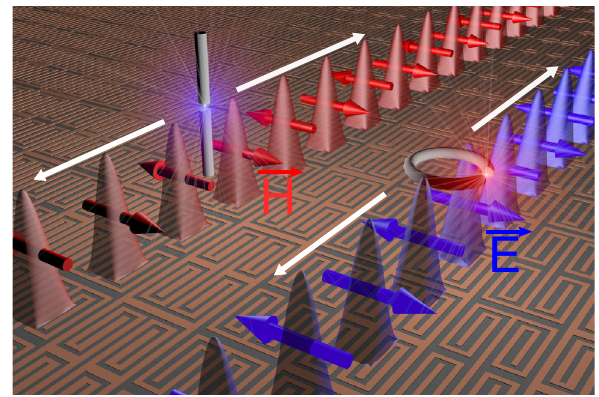
EH FIG. 2. Artistic representation of the canalized and polariza- tion-degenerate surface waves at the self-complementary meta- surface under study. The red and blue arrows demonstrate the instantaneous direction of magnetic and electric fields of TM and TE surface plasmons excited by vertical electric (probe) and magnetic (loop) dipolelike sources, respectively. The conical shapes schematically show the field amplitude sharply decreasing with distance from a metasurface. The white arrows correspond to the wave propagation directions emulating the canalization propagation regime of the surface plasmon-polaritons.